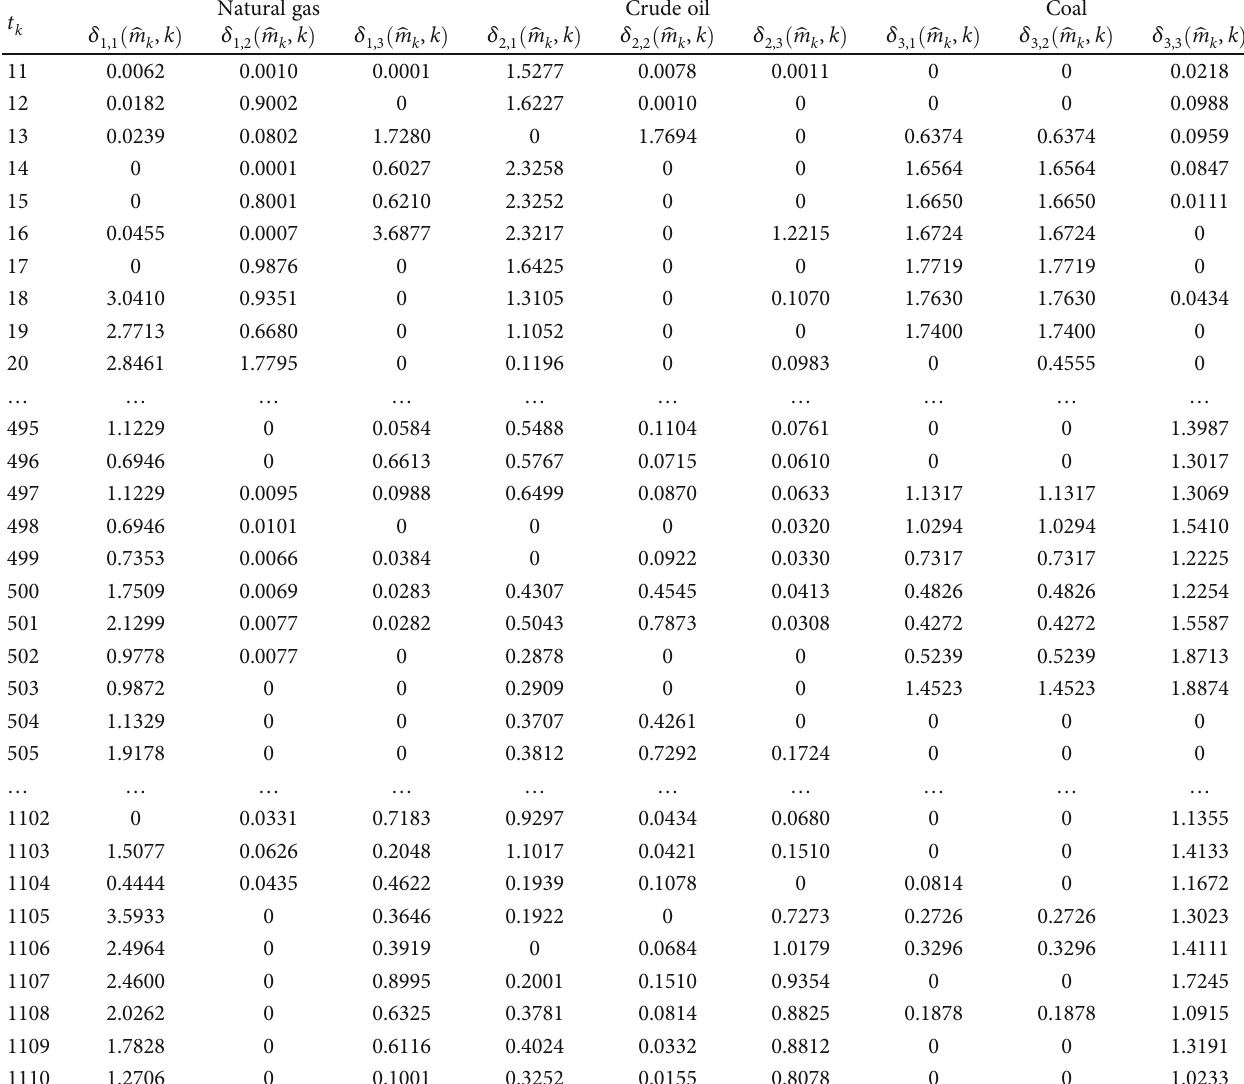
ð ̂ m , k Þ , δ 1,2 k